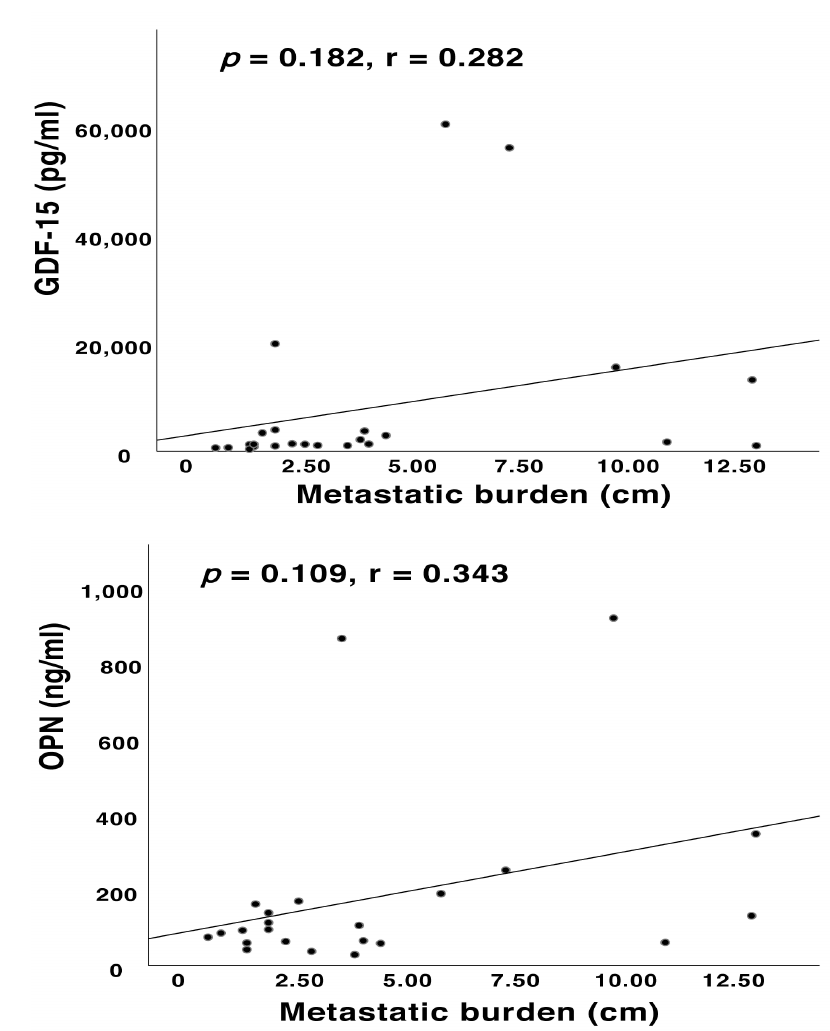
Figure 2. ( a , b ) The Pearson’s correlations between the metastatic burden and the blood-based levels of GDF-15 and OPN, respectively.